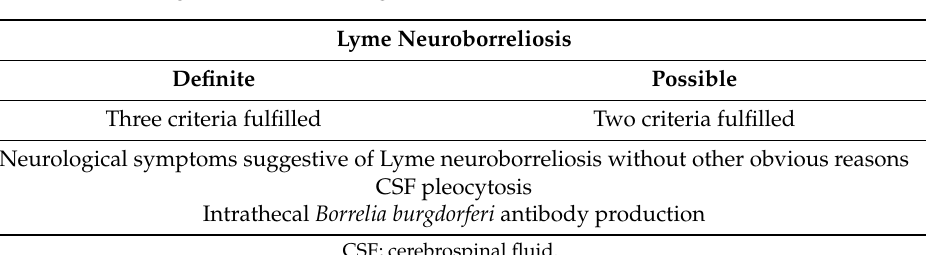
Table 2. Diagnostic criteria for definite and possible Lyme neuroborreliosis according to the European Federation of Neurologic Societies (EFNS)